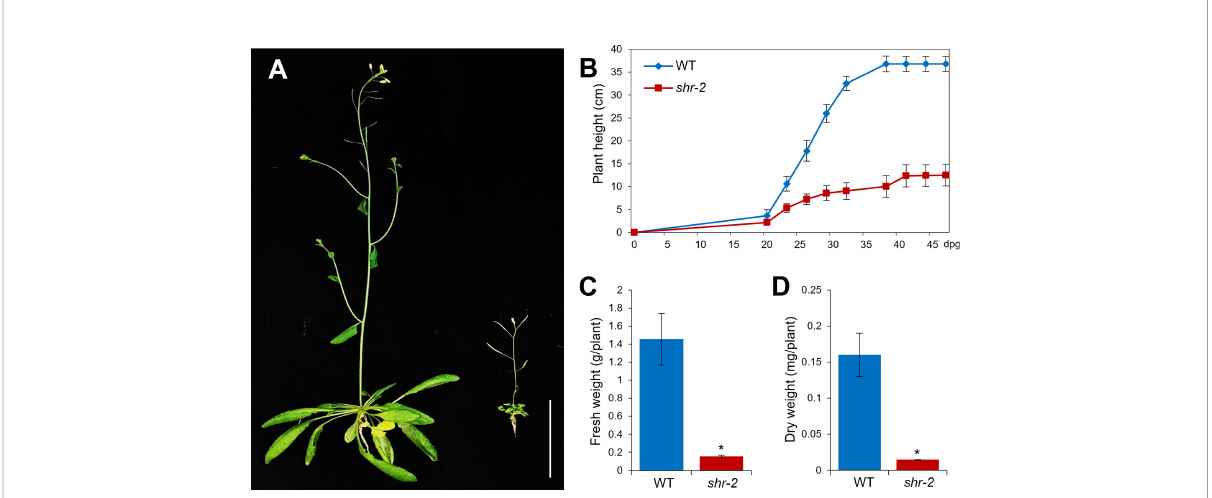
FIGURE 2 Shoot growth phenotypes of Arabidopsis wild-type (WT) and shr adult plants. (A) Approximately 6-week-old WT and shr-2 plants. Scale bar: 5 cm. (B) Lengths of in fl orescence stems of WT and shr-2 plants at different time points (dpg: days postgermination). (C) Fresh weights of ~6- week-old WT and shr-2 plants. (D) Dry weights of ~6-week-old WT and shr-2 plants. The data are shown as mean ± SEM (n > 30). Statistical signi fi cance was determined by Student ′ s t -test compared with WT (* P <